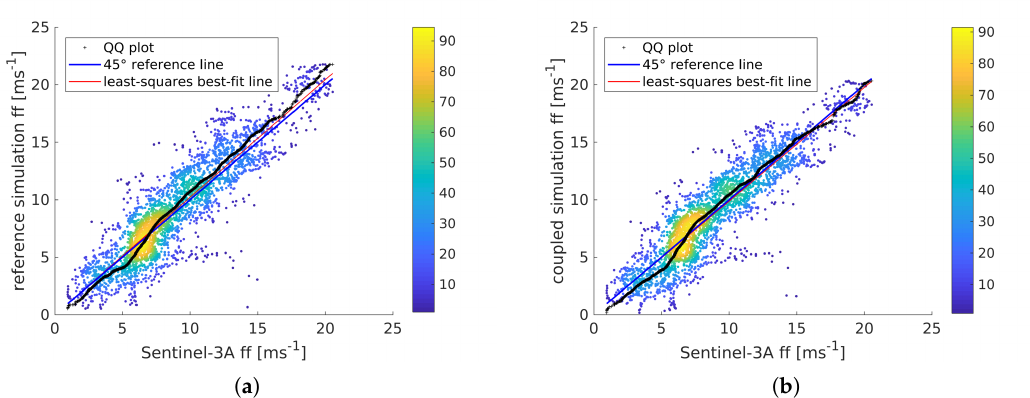
Figure 4. Q–Q scatter plots for the measured (Sentinel-3A) wind speeds and modelled wind speeds with the ( a ) reference and ( b ) coupled model simulations for January 2017. The Q–Q plot is shown as black crosses, the 45 ◦ reference line is denoted by the blue line, and the least-squares best-fit line is the red line.